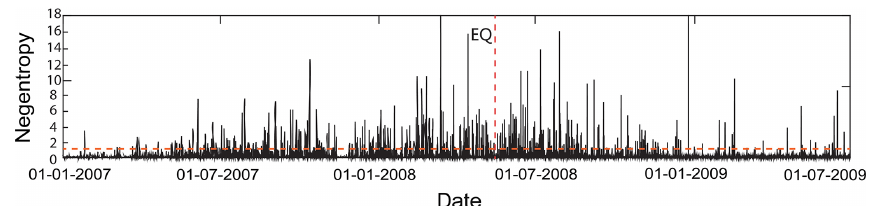
Figure 4. Negentropy at Guza from 1 January 2007 to 30 June 2009. The red dotted horizontal line is the optimal threshold k ∗ calculated by Otsu method.